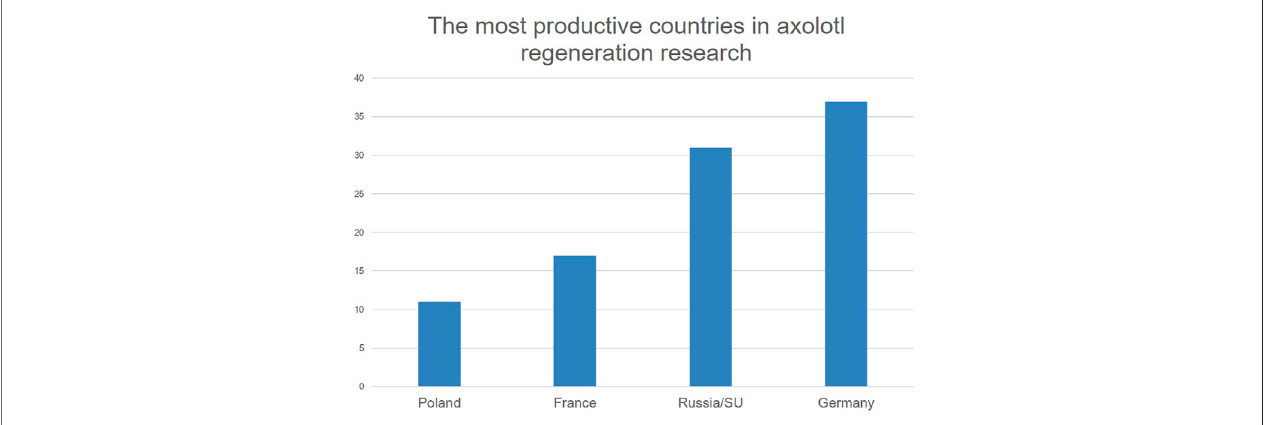
FIGURE 3 | Regeneration research on the axolotl by country from 1864 to 1933. Please note that I assigned the papers to the territorial status at the time of their publication. For data, see Reiß (2020).